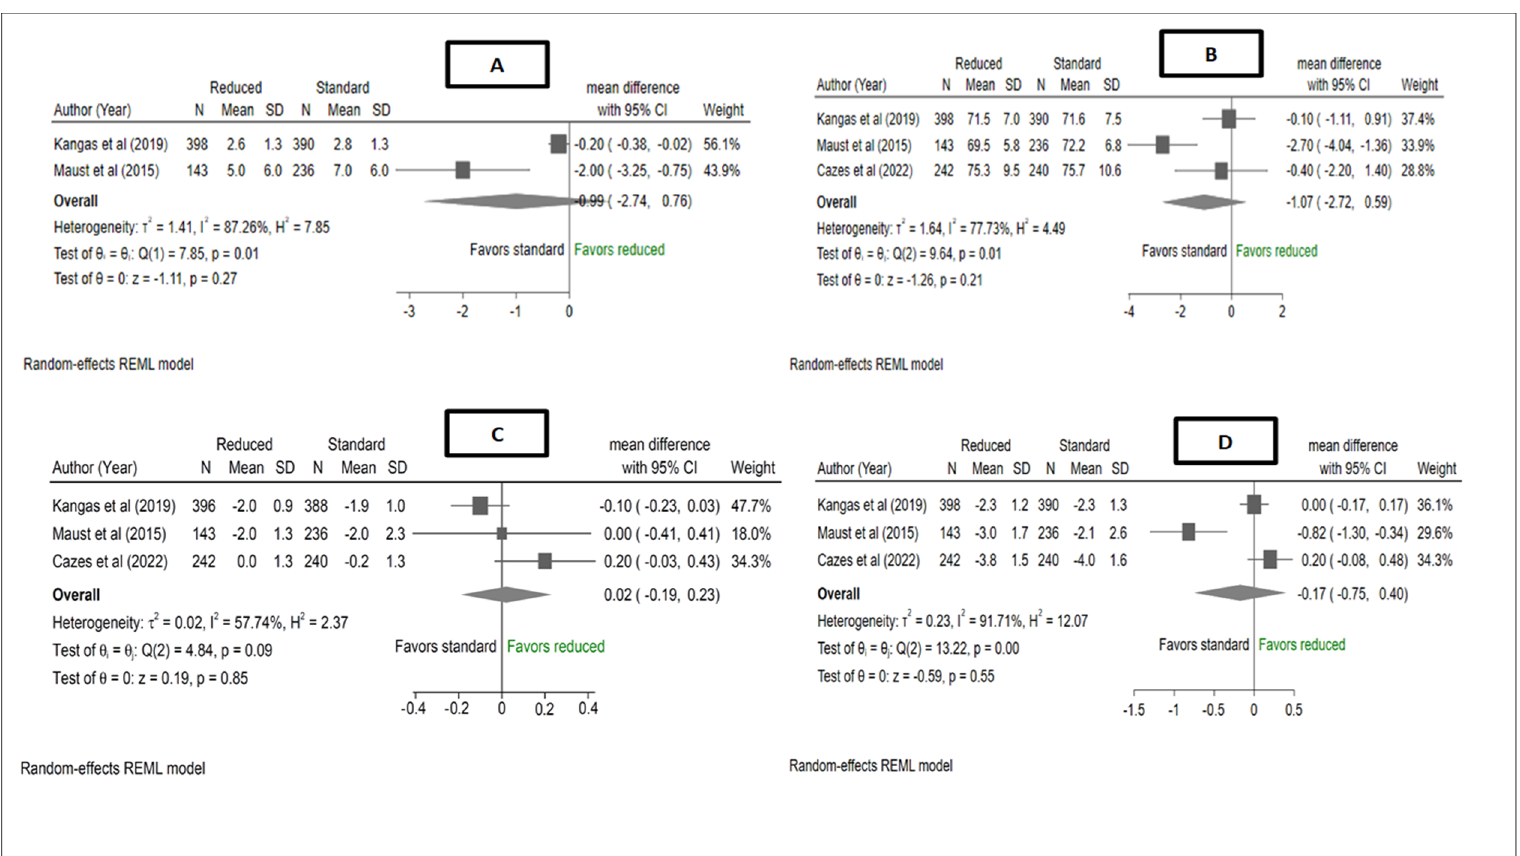
Figure 4. Forest plot of ( A ) mean height, ( B ) rate of height gain, ( C ) mean change in HAZ, and ( D ) WHZ at recovery (Kangas et al. and Maust et al. [12,13]) and 6 months (Cazes et al. [14]) from a meta-analysis of studies comparing reduced RUTF dose with standard RUTF dose for the treatment of severe wasting and/oedema. Effect estimates for Cazes et al. and Maust et al. (means and standard deviations) were obtained directly from the authors. Mean height in Kangas et al. and Maust et al [12,13]. were assessed at recovery, whereas, for Cazes et al. [14], it was assessed at 6 months. Mean HAZ in Kangas et al. [12] was assessed at recovery whereas, for Cazes et al. [14], it was assessed at 6 months from baseline. Mean WHZ in Kangas et al., and Maust et al. [12,13] was assessed at recovery, whereas, for Cazes et al. [14], it was assessed at 6 months from baseline. Only ITT results were meta-analysed, for all studies.